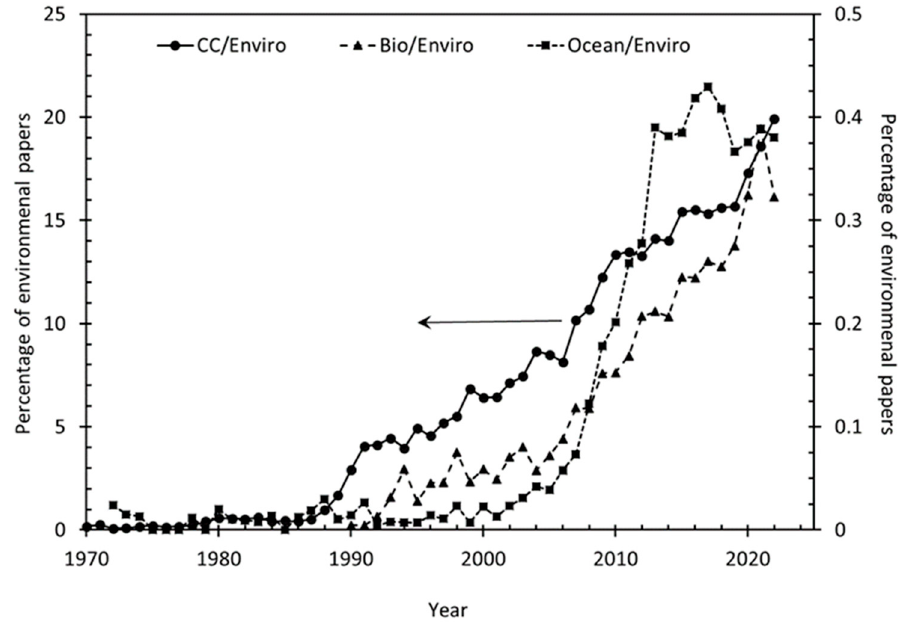
Figure 1. Scopus counts from 1970 to 2022 for articles on climate change (CC), biodiversity loss (Bio) and ocean sustainability (Ocean), normalized by all environment articles. Note left-hand scale for CC papers.